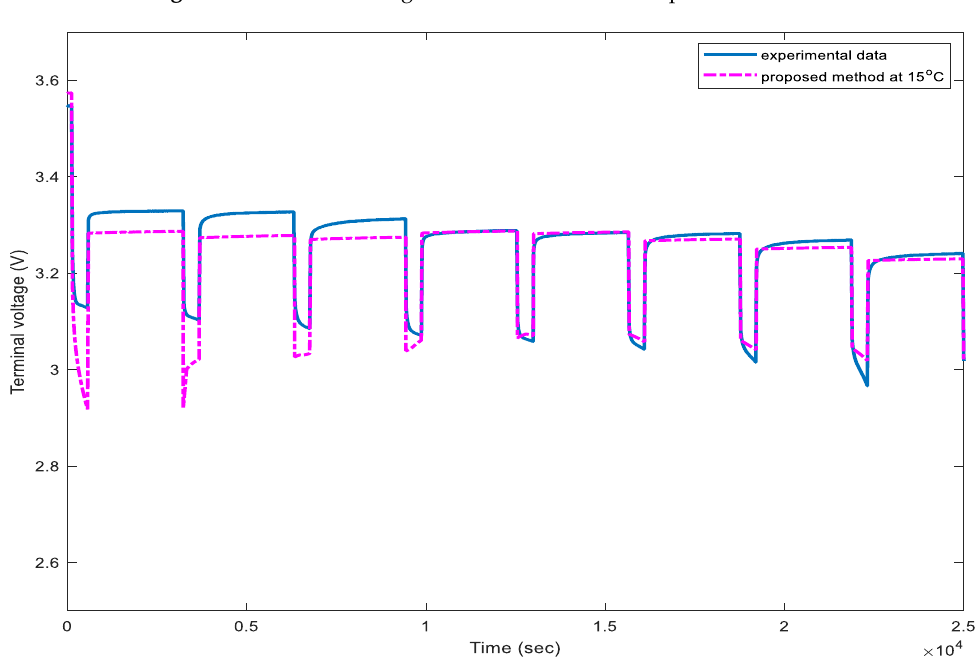
Figure 16. Terminal voltage at different ambient temperature of 15 °C.